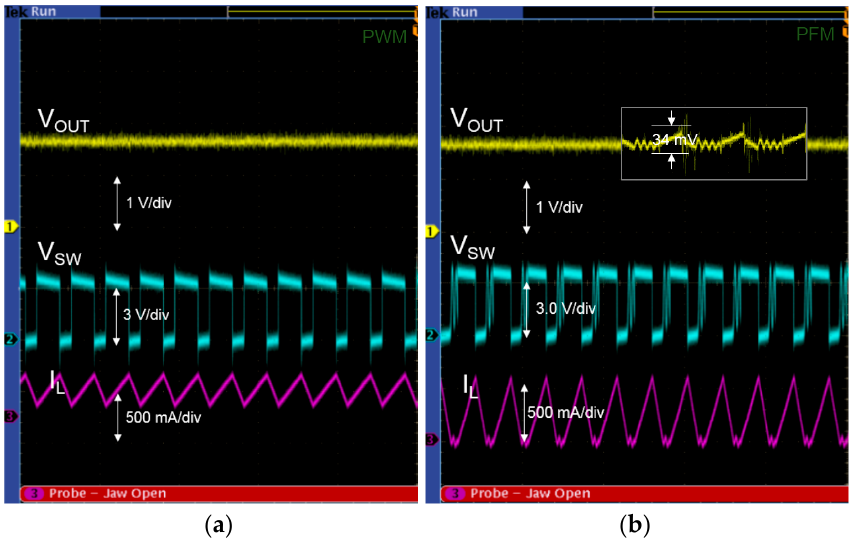
Figure 17. Measurement results for the fabricated chip in standard mode: ( a ) PWM mode (I OUT = 250 mA); ( b ) pulse-frequency modulation (PFM) mode (I OUT = 150 mA).